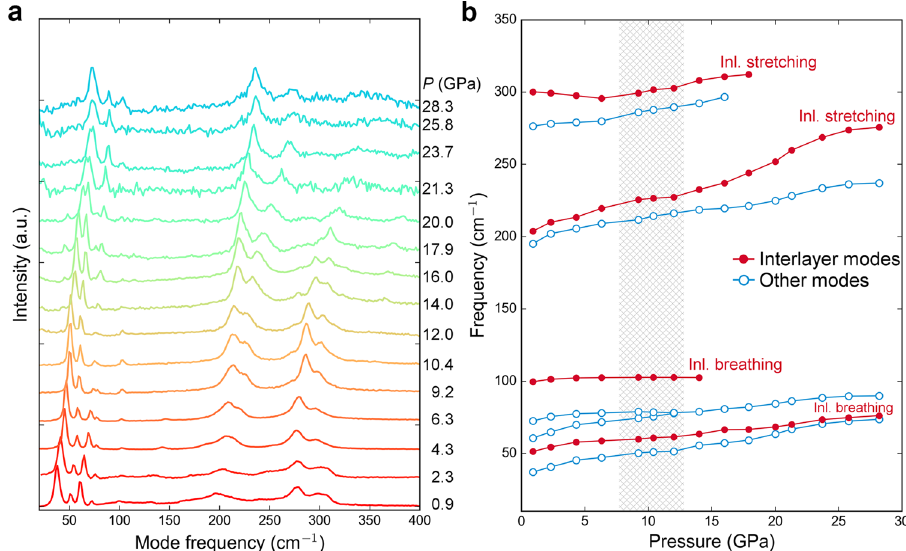
Fig. 2 Low-frequency Raman spectroscopy to 28.3 GPa. a Raman spectra of compressed Sb 2 S 3 in the range of 0 – 400 cm − 1 wavelength. The asterisk peaks were not traceable thus not assigned to speci fi c modes. b Evolution of each Raman mode over pressure. The frequency of peak has maximum uncertainty of 5 cm − 1 . Mode displacements are derived from the fi rst-principles simulation at low pressure. Inl interlayer.